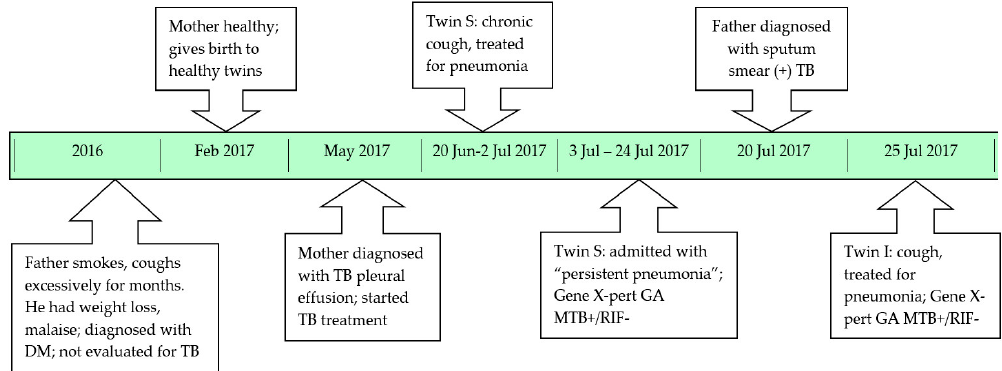
Figure 2. Timeline of the family’s diagnostic journey resulting in twin infants being diagnosed with microbiologically confirmed tuberculosis. TB—tuberculosis; DM—diabetes mellitus; GA—gastric aspirate; MTB— Mycobacterium tuberculosis ; RIF—Rifampicin.